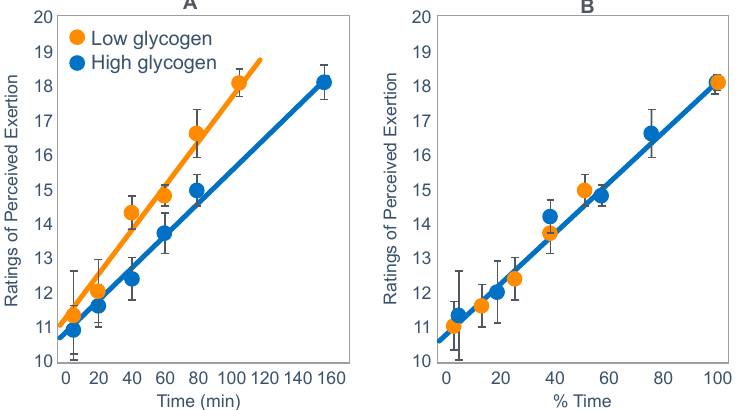
Figure 19. Ratings of perceived exertion (RPE) rose as a linear function of absolute exercise durations in the study of Baldwin et al. [42] in subjects who began exercise with either low or high muscle glycogen content (panel A ). When the same data are expressed as a function of relative (%) time, (panel B ) the lines overlap. Thus, the RPE rises as a linear function of the expected duration of the exercise that is being performed. Adapted with permission from ref. [116]. Copy-right Year 2004 American Physiological Society.